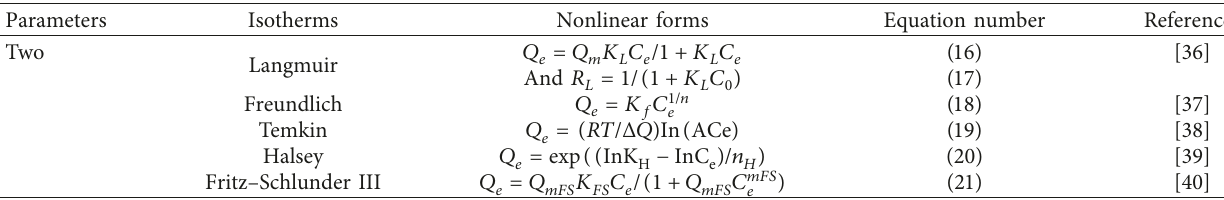
Table 5: Isotherm